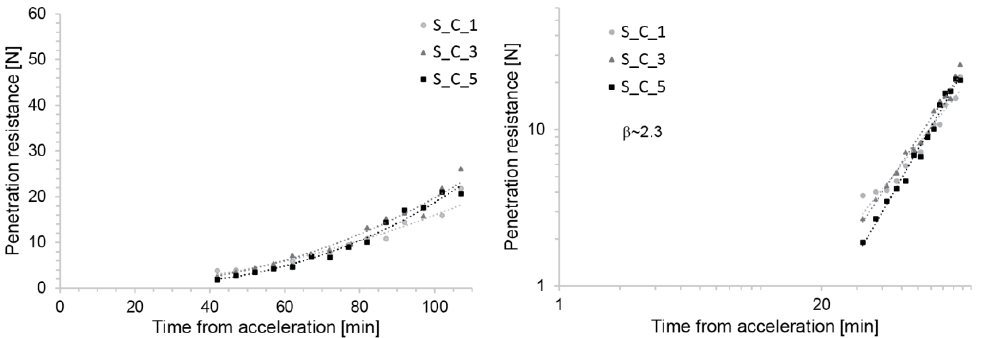
Figure 4. Strength evolution of the S_C Mix with C100 accelerator with increased dosage over time. ( Left ) Lin-lin scale reproduced from [11]. ( Right ) Log-log scale. The straight line obtained on the log-log scale highlights the fact that the yield stress evolution can well be fitted by a power-law (see Equation (3)).